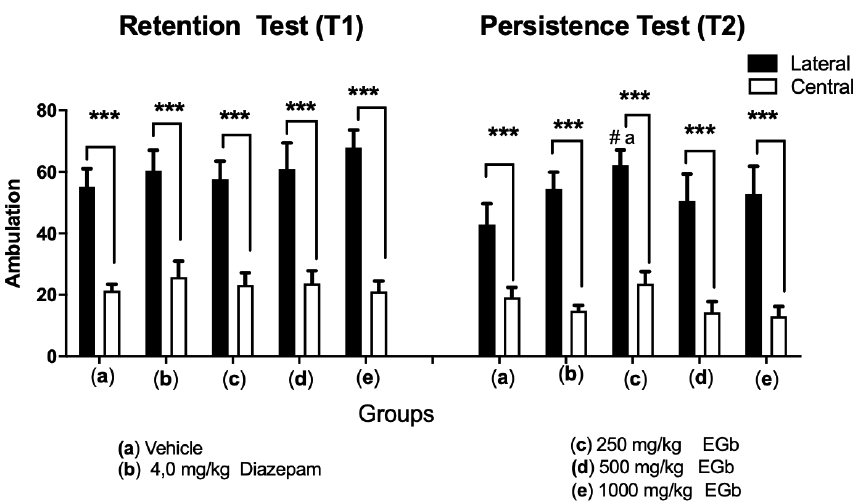
Figure 2. Number total of central and lateral square crossings (ambulation) in the control groups (4 mg/kg diazepam- and vehicle-treated group) and the groups treated with EGb (250 mg/kg; 500 mg/kg and 1000 mg/kg) during the retention test (n = 20/group) and persistence test (n = 10/group). The values are expressed as the mean values/ min (± SEMs). *** p < 0.0001; two-way ANOVA followed by post hoc Tukey’s multiple comparison t est. # p < 0.05 denotes a difference within (n = 10/group). The values are expressed as the mean values/ min ( ± SEMs). *** p < 0.0001; groups. between sessions comparisons. two-way ANOVA followed by post hoc Tukey’s multiple comparison test. # p < 0.05 denotes a difference within groups. between sessions